Question: Judging by this figure, is the value going up or going down?
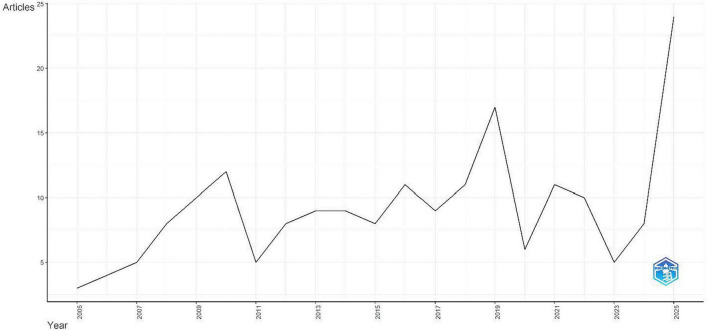
Answer: increasing